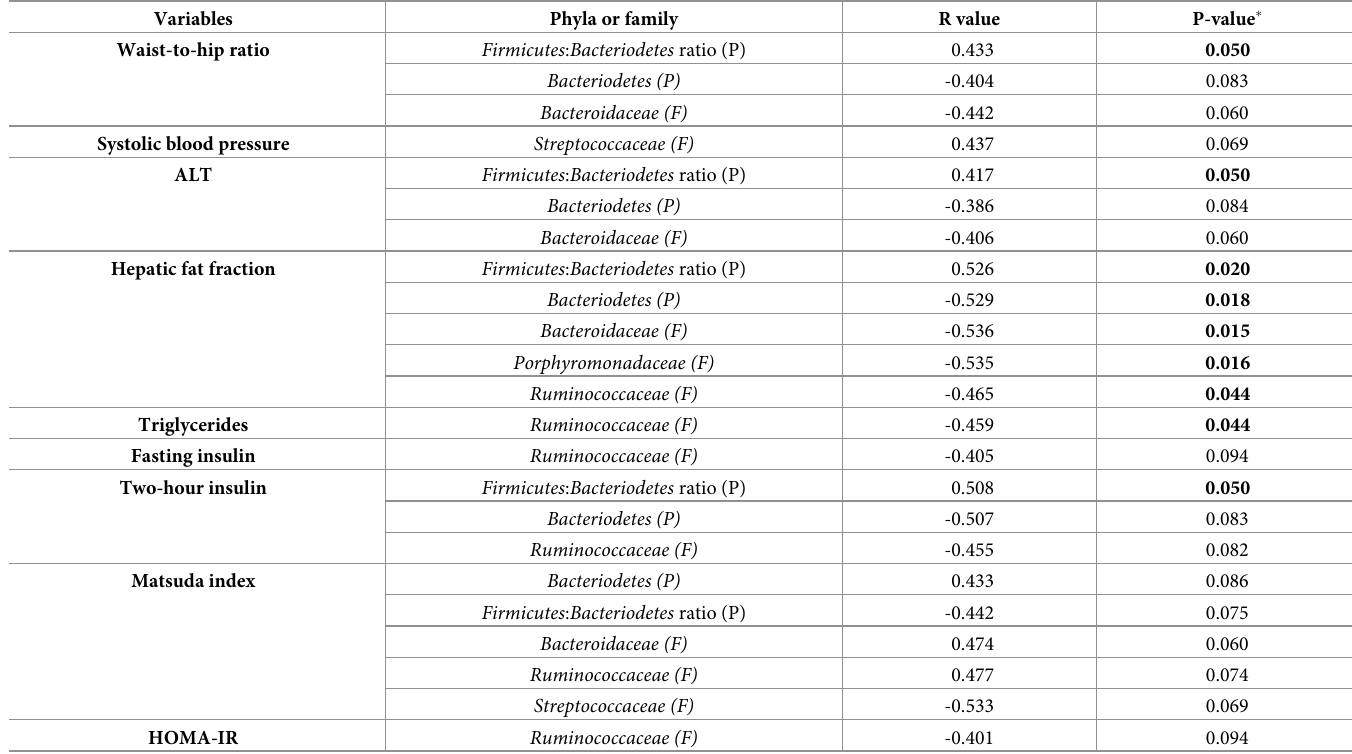
Table 2. Correlations between clinical measurements and percent relative abundance of bacterial taxa.